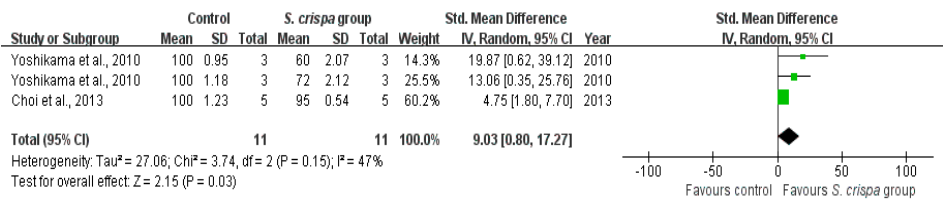
Figure 11. Comparison of DPPH radical scavenging activity between control and S. crispa groups. ): SMD of individual studies; (  ): summary SMDs of the comparison. Figure 8. Comparison of inflammatory cells survival between control and S. crispa groups. ( ): Figure 8. Comparison of inflammatory cells survival between control and S. crispa groups. ( ): SMD of individual studies; (  ): summary SMDs of the comparison. Figure 4. Comparison of the survival of cancer cells between control and S. crispa groups. ( Figure 9. Comparison of the anti-fungal activity between control and S. crispa groups. ( ): SMD of Figure 6. Comparison of the IFN- γ production potential between control and S. crispa groups. ( SMD of individual studies; (  ): summary SMDs of the comparison. ): summary SMDs of the individual studies; (  ): summary SMDs of the comparison. SMD of individual studies; (  ): summary SMDs of the comparison.